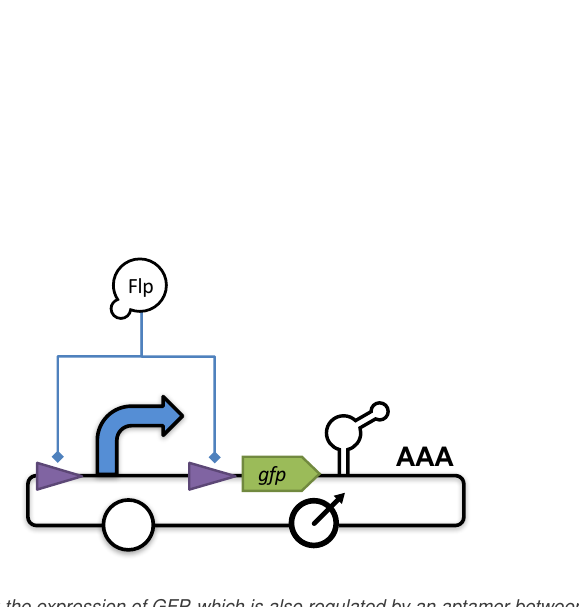
Figure 34: Promoter regulating the expression of GFP, which is also regulated by an aptamer between it and the poly-A tail of the transcript. The promoter can be cut out by a pair of recombinase target sites, which are acted on by the Flp protein. The whole construct is stored in a circular plasmid with an origin of replication and also an origin of transfer.